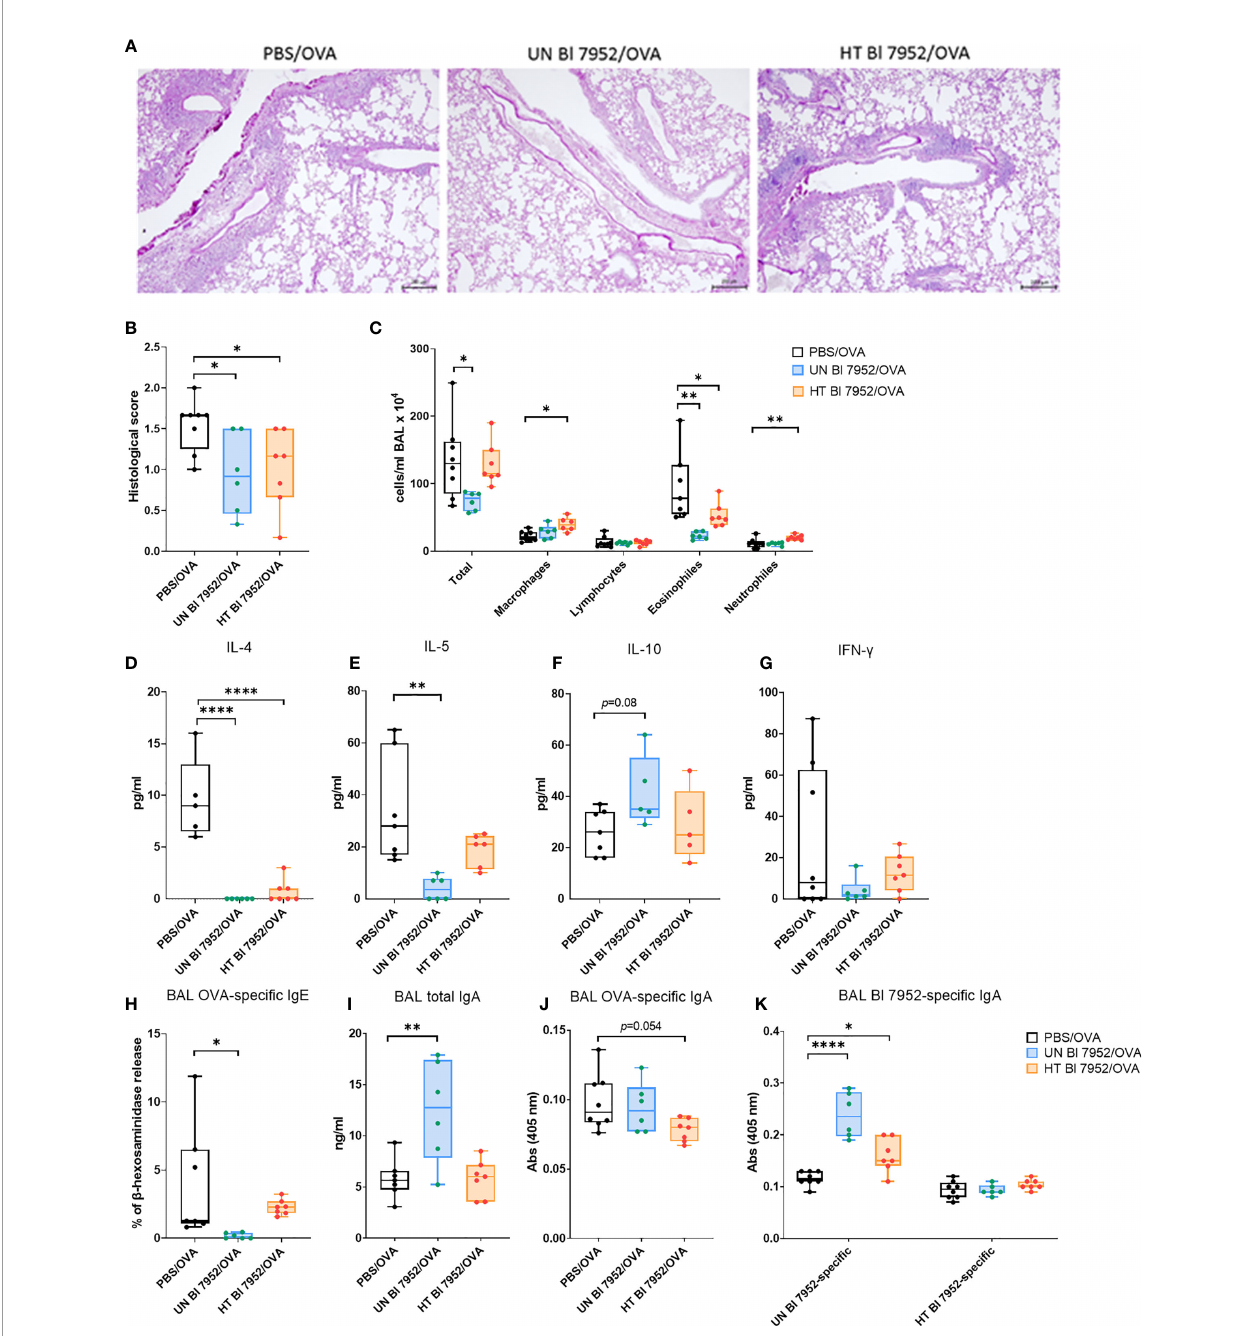
FIGURE 6 | Intranasal administration of untreated and heat-treated Bl 7952 differently reduces allergic in fl ammation in lungs of OVA-sensitized mice (A) Representative tissue section Periodic Acid-Schiff staining of the lungs from OVA-sensitized and challenged mice pre-treated with PBS (PBS/OVA, black box), untreated Bl 7952 (UN Bl 7952/OVA, blue box) and heat-treated Bl 7952 (HT Bl 7952/OVA, orange box) strain. Scale (200 m m) applies to all presented images, magni fi cation ×100. (B) In fl ammatory score of the lungs was determined by histopathological analysis. (C) Total and differential cell counts were determined in bronchoalveolar lavage (BAL). Levels of spontaneous cytokine production from BAL fl uid (D) IL-4, (E) IL-5, (F) IL-10 and (G) IFN- g were expressed as pg/ml. (H) OVA-speci fi c IgE was determined in BAL fl uid as % of b -hexosaminidase release assay. (I) Total IgA in BAL fl uid was measured by ELISA and expressed as ng/ ml. (J) OVA-speci fi c IgA and (K) untreated or heat-treated Bl 7952-speci fi c IgA were determined in BAL fl uid as optical density ( l = 405 nm). Results are shown as boxplot means and min to max value bars; each dot represents a single mouse. Signi fi cant difference between PBS/OVA and bi fi dobacteria-treated/OVA experimental groups was calculated by one-way ANOVA with Dunnett ’ s multiple comparison test *p <.0.05. **p < 0.01, ****p <